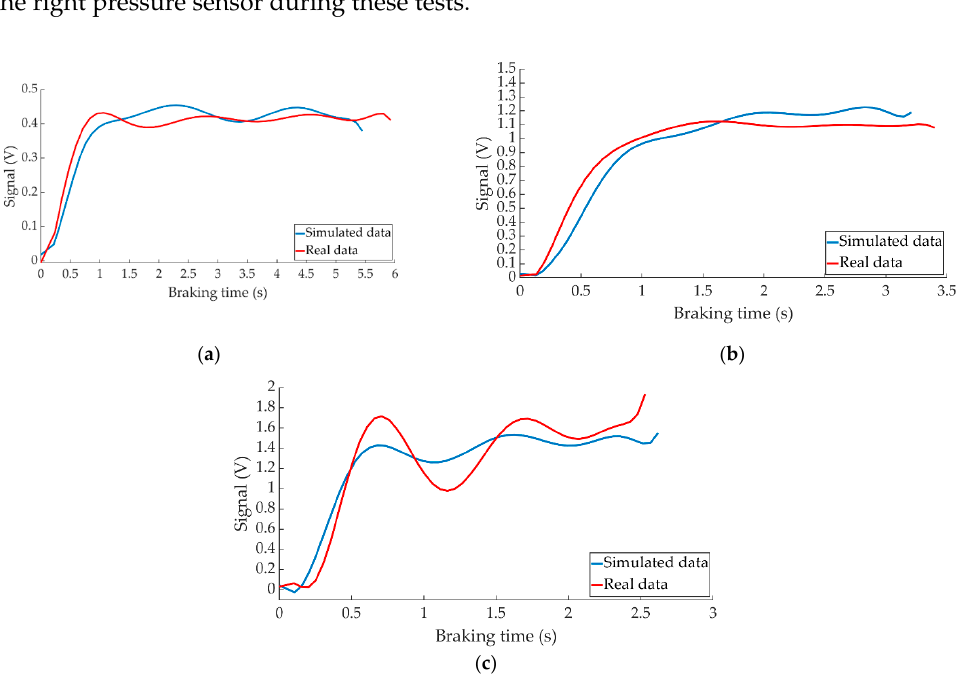
Figure 24. Comparison between the ANN-simulated data and actual data collected by the right pressure sensor for braking at a speed of 70 km/h for the type: ( a ) maintained, ( b ) progressive and ( c ) emergency.